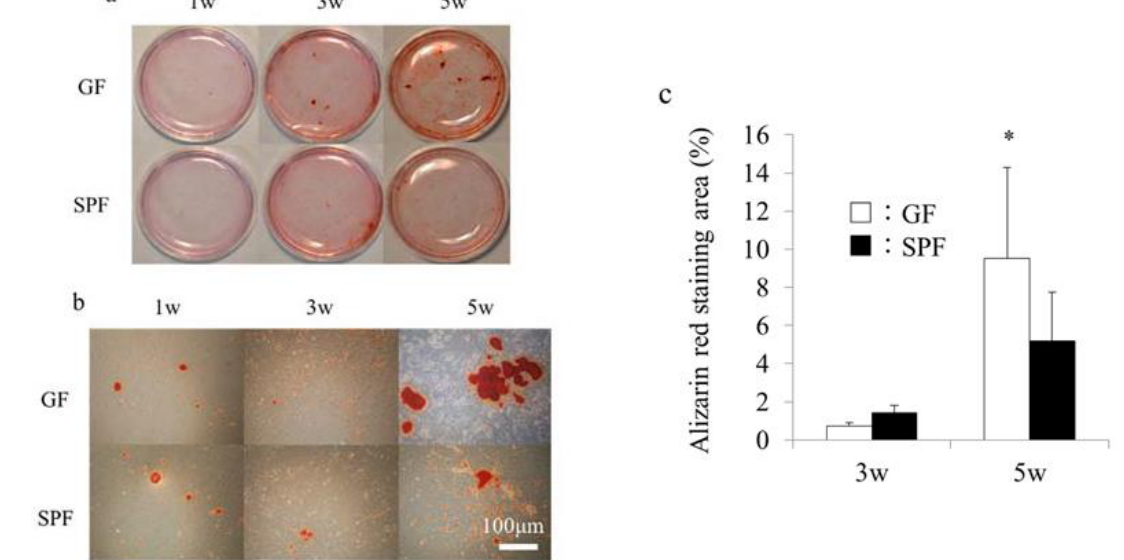
Figure 4. Calcification in cultured primary osteoblasts from germ-free (GF) and specific pathogen-free (SPF) mice. Calvariae from 8-week-old GF and SPF male mice were harvested, and primary osteoblasts were isolated and cultured in osteoblastic differentiation media. ( a ) Alizarin red staining of osteoblasts from GF and SPF calvariae cultured for 1, 3, and 5 weeks. Panel ( b ) shows high-magnification fields of panel ( a ). ( c ) The alizarin red–positive area was calculated using a computerized imaging system (ZEN, ZEISS, Oberkochen, Germany). The alizarin red–positive area at 5 weeks was significantly greater in SPF mice than GF mice. Mean values (±SD) are shown * p < 0.05, t -test ( n = 4/group). Scale bar = 100 μm ( b ).